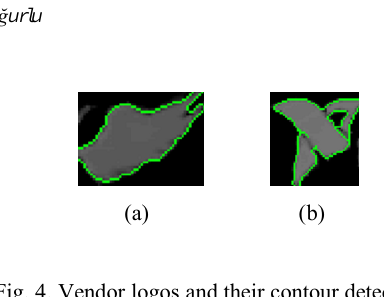
Fig. 4. Vendor logos and their contour detections: